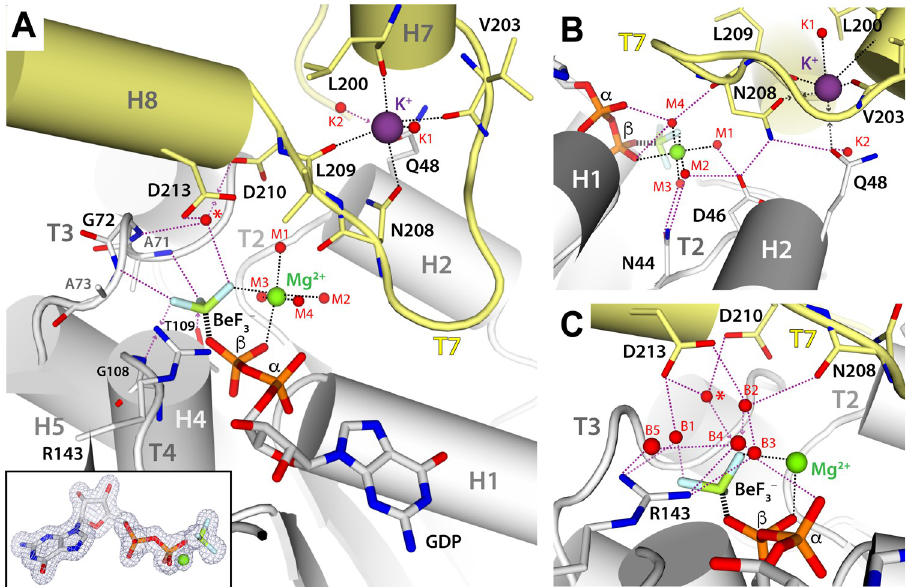
Fig 3. Nucleotide-binding pocket in the SaFtsZ structure complexed with GDP, BeF 3 − , and Mg 2+ . (A) Overall view of the interface between adjacent subunits. Inset: Polder OMIT map around the nucleotide mimetic and Mg 2+ ion. (B) Zoom around the T7-H2 contact region. (C) Zoom around bridging water molecules. In all panels, structural elements and relevant residues are labeled, while Mg 2+ , K + , and water are represented as green, purple, and red spheres, respectively. A red star indicates the precatalytic water. For clarity, certain solvent molecules, coordination contacts (black dash), and H-bonds (purple dash) are omitted in different panels.